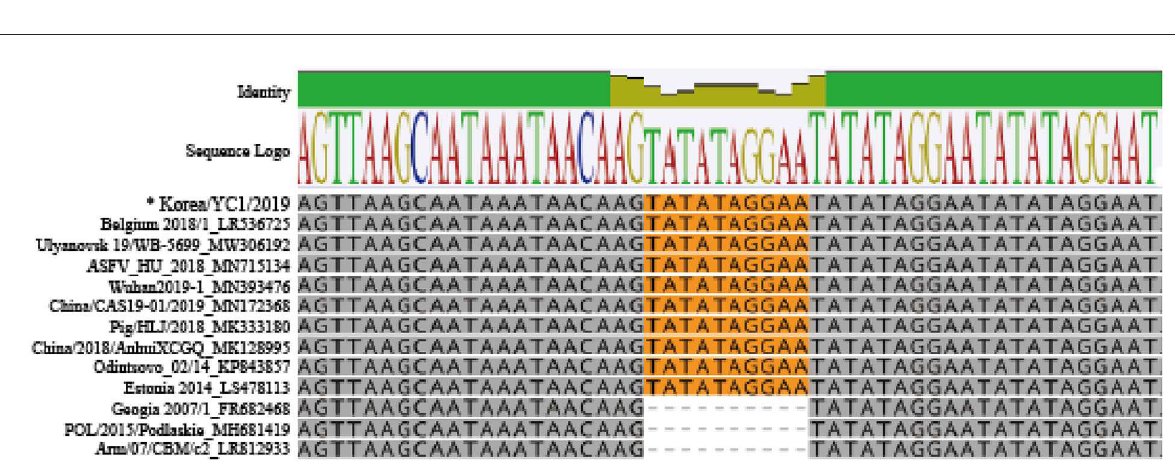
Korea/YC1/2019 strain is closely clustered with genotype II ASFVs, providing insights into the 2019 ASF